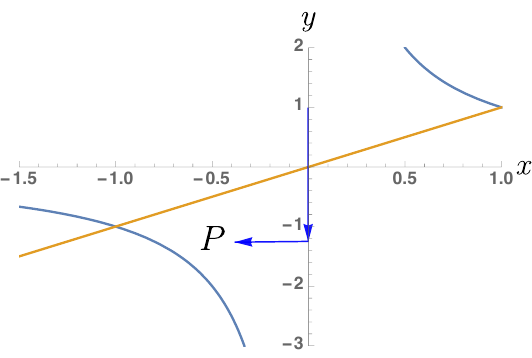
Figure 11. Integrating to a point P in the physical